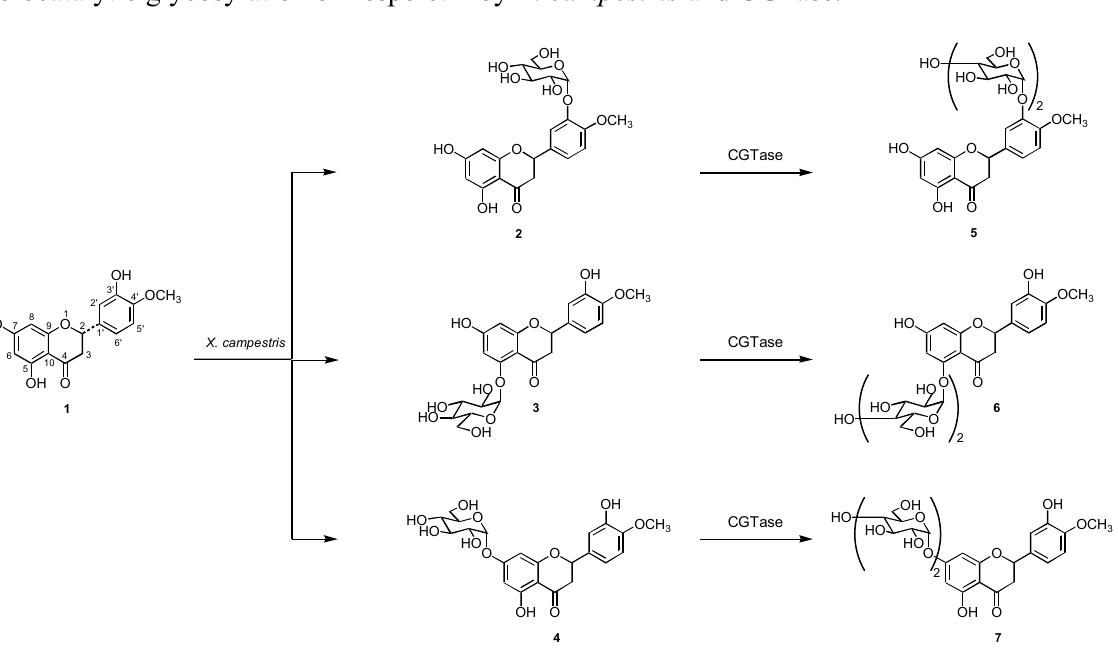
Figure 1. Synthetic route of α -glucosides and α -maltosides of